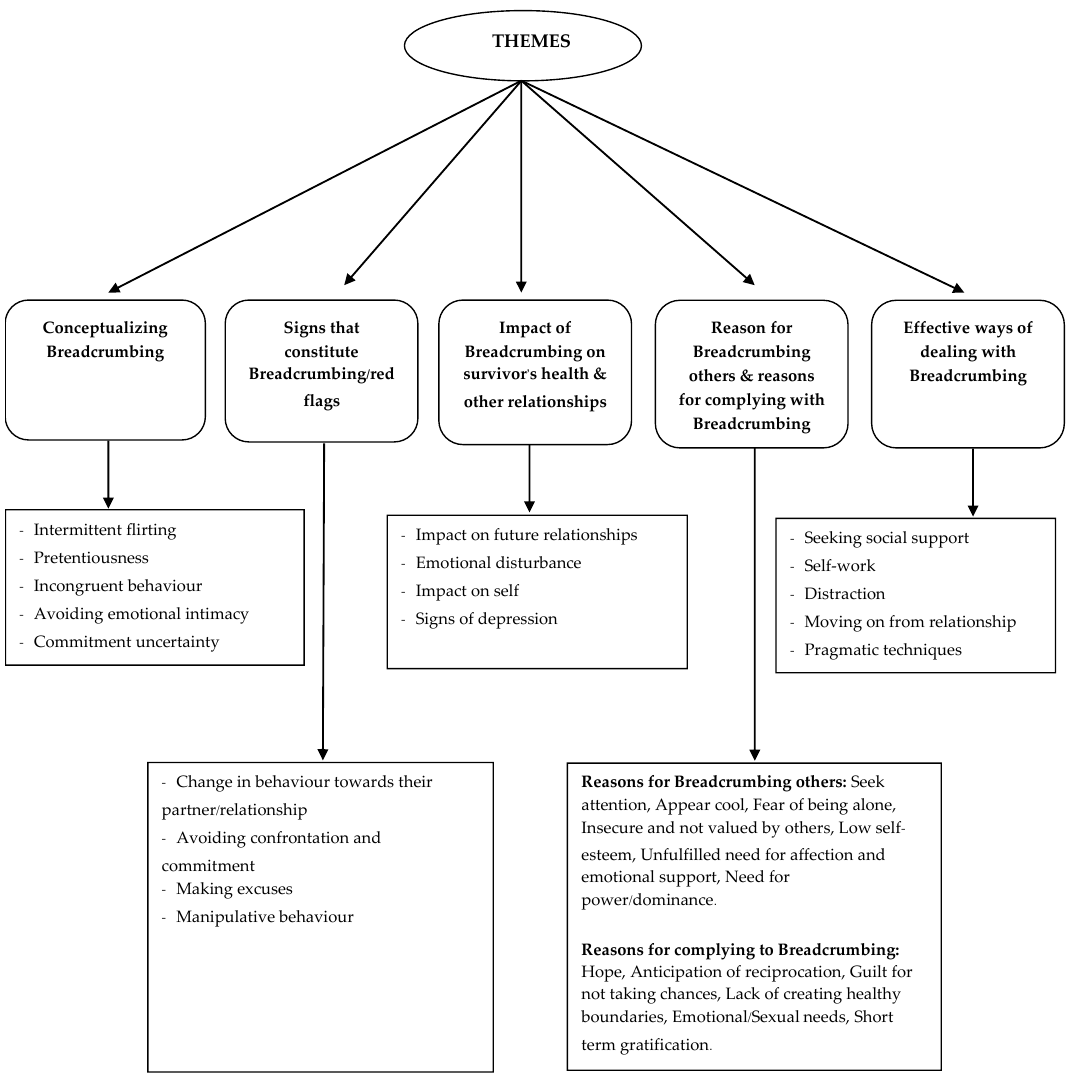
Figure 1. Themes of Breadcrumbing.